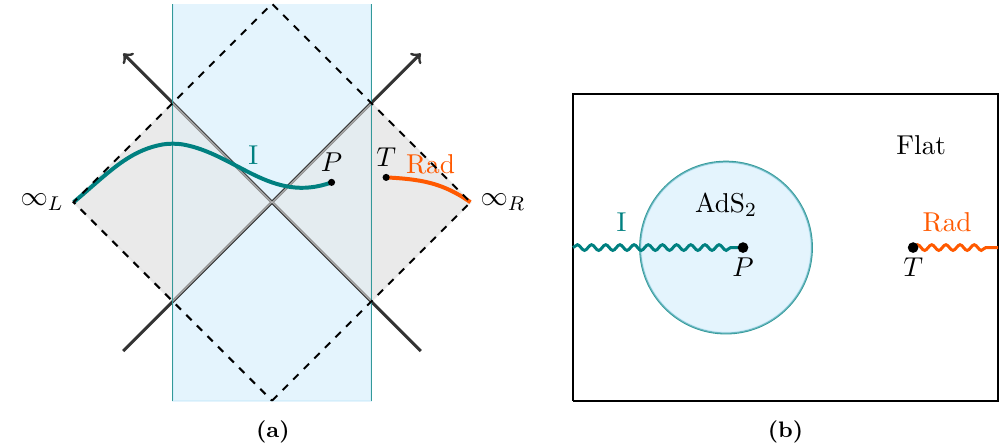
Figure 5. (a) The Lorentzian setup of the island configuration with the region Rad ∪ I = ( ∞ L , P ] ∪ [ T, ∞ R ) . The island region I purifies the entanglement between the left and right Rindler wedges and makes the entanglement entropy of Rad finite. (b) The Euclidean configuration where the Hartle-Hawking vacuum is prepared for the AdS 2 black hole plus flat bath. Since it is a pure state in the whole space, the entanglement entropy of Rad ∪ I equals that of the complementary region Rad ∪ I = [ P, T ]